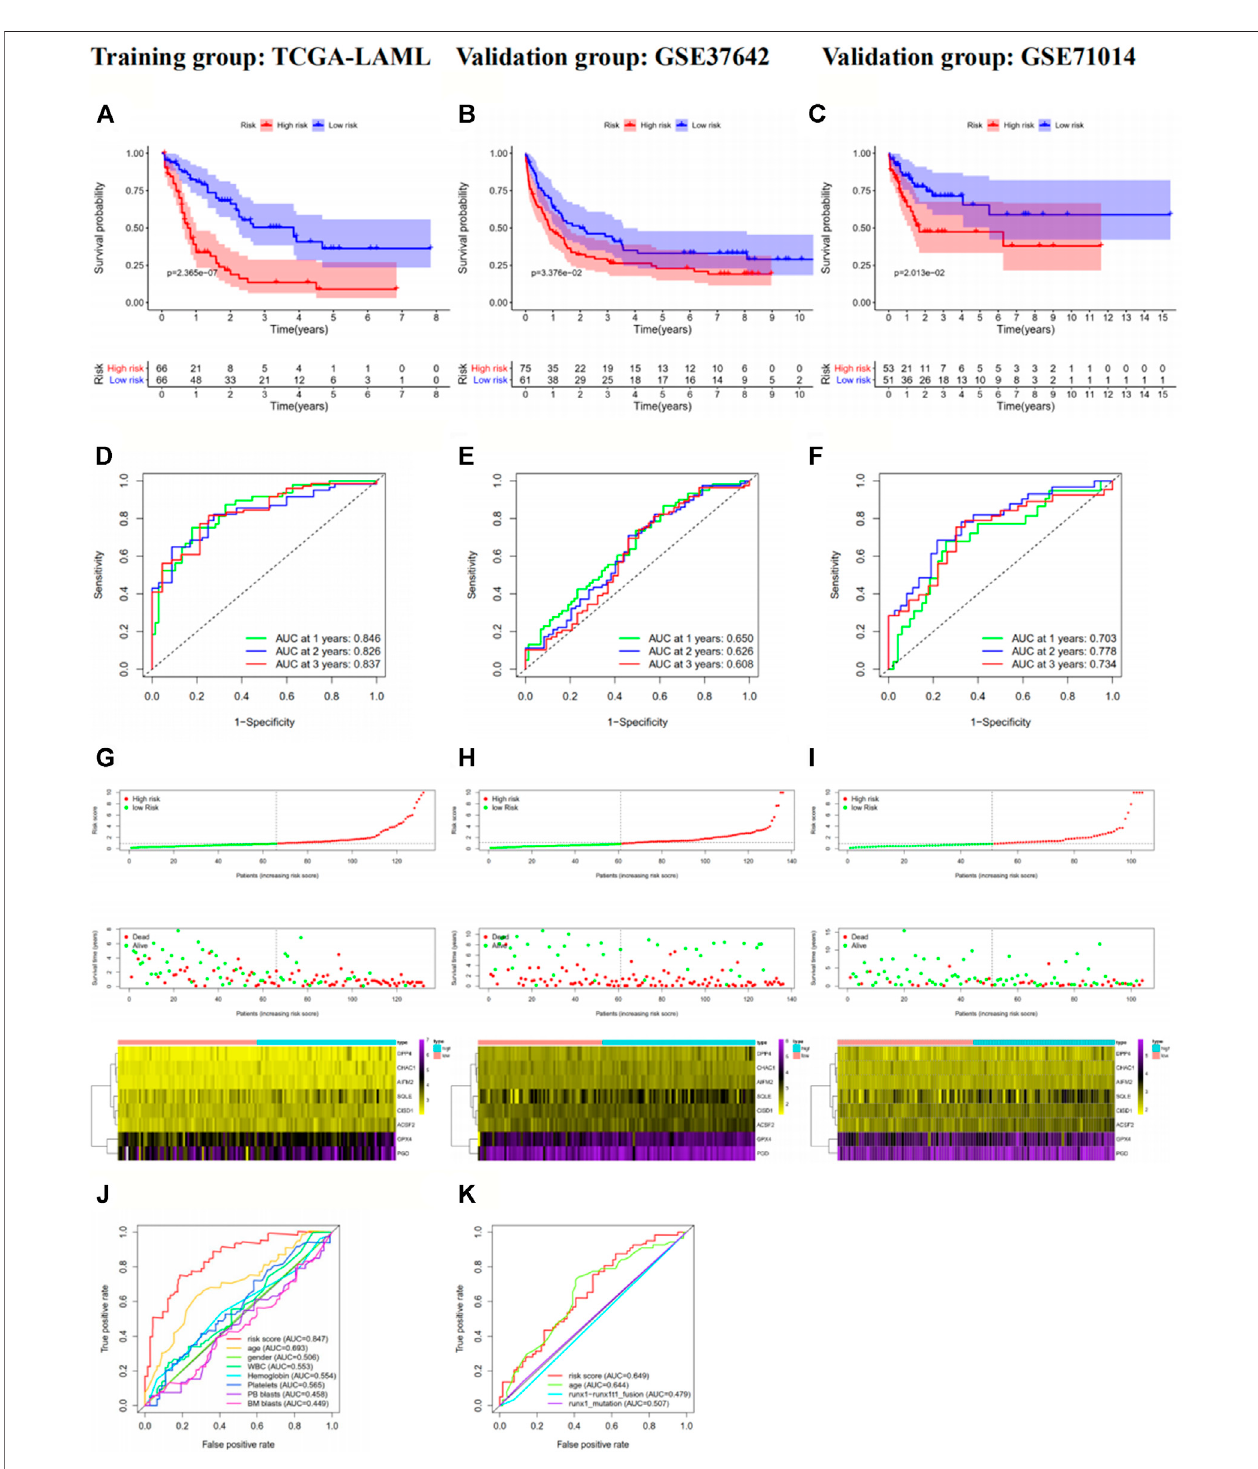
FIGURE2| Prognosticanalysisoftheeight-genesignatureinthetraininggroupTCGA-LAML (A,D,G, and J) ,validationgroupGSE37642-GPL570 (B,E,H, and K) andvalidationgroupGSE71014 (C,F, and I) .Inthesurvivalcurve (A – C) ,thenumberofsurvivingpatientsdecreasedovertime. p < 0.05indicatessigni fi cantdifferencesin survivalbetweenthetwogroups.Intheriskscorecurve( G-I ),thetopshowstheriskscoreforeachpatient;greendotsrepresentlow-riskpatients,andreddotsrepresent high-risk patients. The middle shows the distribution of survival status and survival times for each patient, with red dots representing dead patients and green dots representing living patients. The number of deaths increased with increasing risk scores. The bottom is the expression heat map of the eight model genes, with the left showingthelow-riskgroupandtherightshowingthehigh-riskgroup.Thegeneexpressionlevelslargelyincreasewiththeriskscores.IntheROCcurves,weusedtherisk score as the only feature for 1-, 2-, and 3-years OS (D – F) . In addition, we compared the 1-year OS prediction accuracy of the risk score with other single clinical characteristics (J – K) . TCGA, The Cancer Genome Atlas; AML, acute myeloid leukemia; ROC, receiver operating characteristic; OS, overall survival.